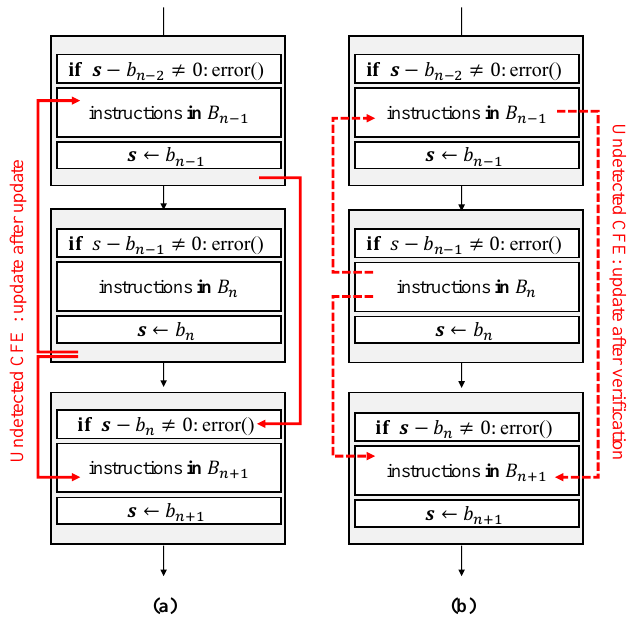
Figure 5. Cases of undetected CFE: ( a ) update after update; and ( b ) update after